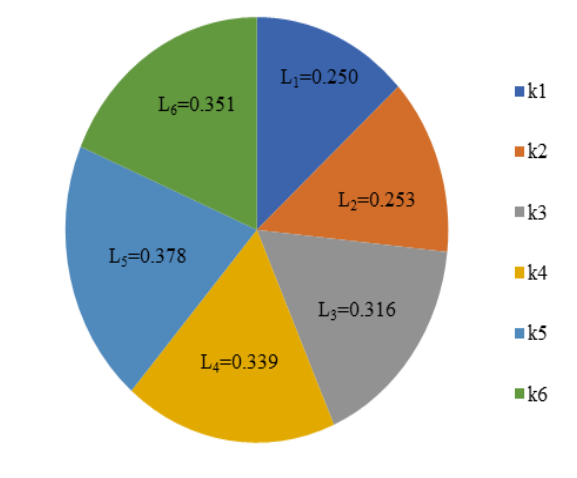
Figure 1. The comprehensive value of the distance between the index vector of 6 teachers and the ideal point